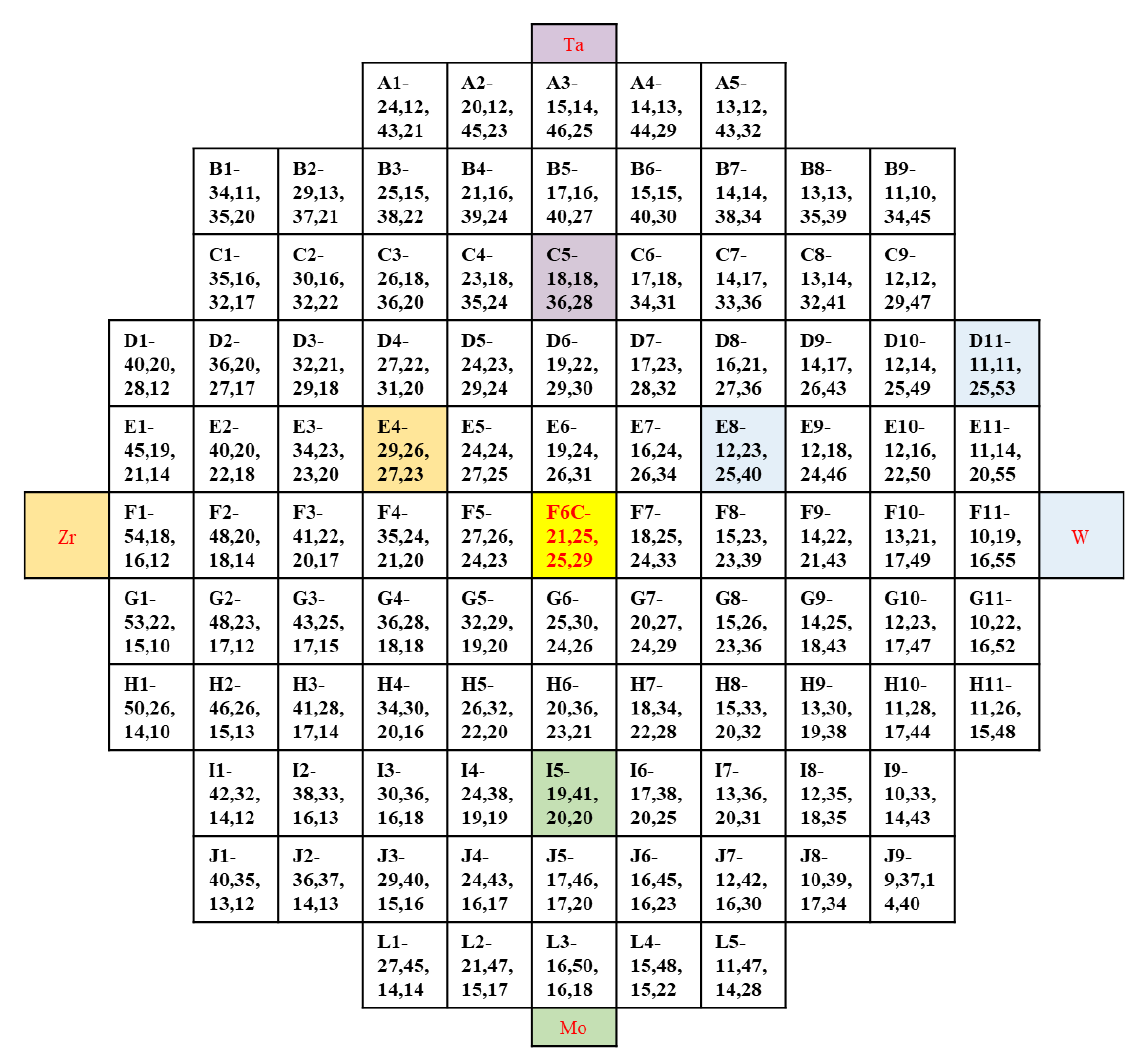
Figure 2. The composition of the 101 sample cells in the film. The corresponding thin film element distribution is shown in Figure 4. Taking sample F6C and sample D11 as an example, the composition of the whole film showed gradient changes, but the local element distribution was uniform. It confirmed local uniformity in the distribution of alloying elements. Khan et al. [26] demonstrated EDS mapping of films grown at different operating pressures and observed uniformity of film deposition. Sha [27] and Malinovskis et al. [28] obtained uniform film by rotating the substrate at a constant speed. In this work, using the four-target co-sputtering technique, it is still possible to obtain the alloy films with the locally uniformly distributed elements. Compared